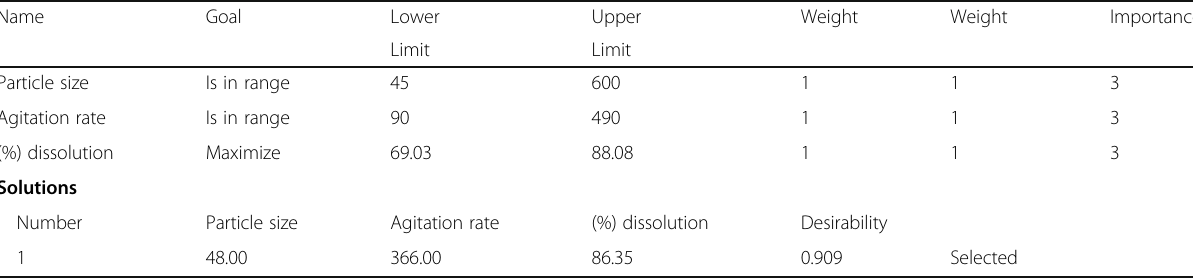
Table 6 Numerical Optimized solutions and values for the quadratic